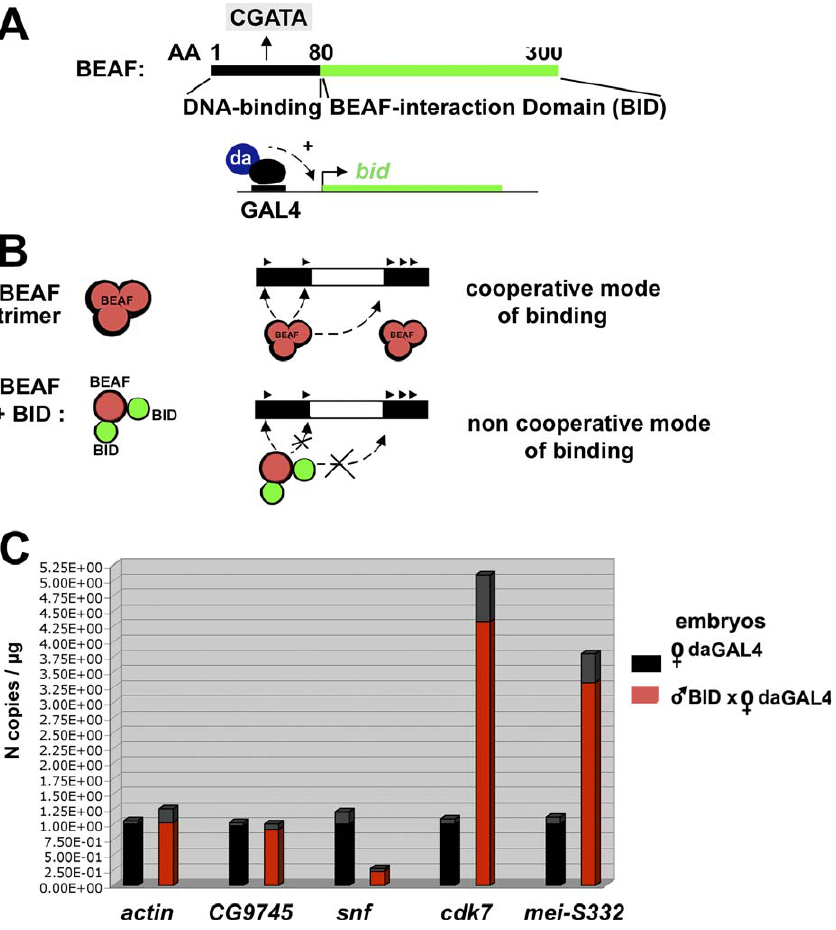
Figure 9. Regulated Gene Expression Requires Cooperative Binding of BEAF to Dual-Cores and Is Impaired by BID (A) Schematic representation of BEAF. Its N-terminus is the DNA binding domain (AA 1–80) which targets one CGATA motif [17,23–25]. Its C-terminus, required for assembly of BEAF complexes, is called the BEAF self-interaction domain (BID; AA 80–280). As a result, expression of BID under the control of the GAL4-daugtherlesss (da) activator in transgenic flies dominantly competes with the cooperative binding of BEAF [25], as represented in (B). (B) Schematic representation showing how the cooperative binding of BEAF complexes to clustered CGATAs of dual-cores is compromised by expression of BID upon its assembly with BEAF subunits. (C) Quantitative RT-PCR analysis in 4–8-hour embryos expressing a GAL4-driven BID transgene. The results are expressed as copy number of amplification products measured for each gene in embryos expressing BID or in embryos expressing the da-GAL4 driver alone. The y -axis shows the number of copies of amplification products per l g of RNA normalized for each gene in control cells, where N ¼ 1 corresponds to 9,900 copies of actin , 11,200 copies of CG9745 , 77,300 copies of snf , 59,400 copies of mei-S332 , and 116,200 copies of cdk7 . Experimental error is denoted by the differentially colored (gray) portion at the top of each bar. Note that BID expression leads to lethality at later stages of development